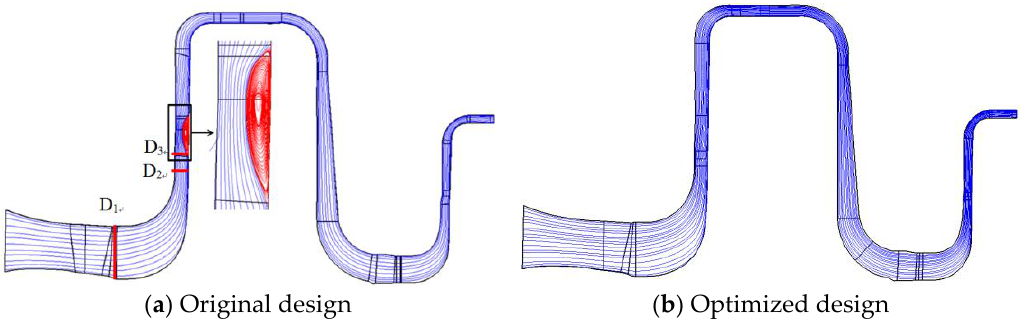
Figure 14. Meridional streamline at 100% load.